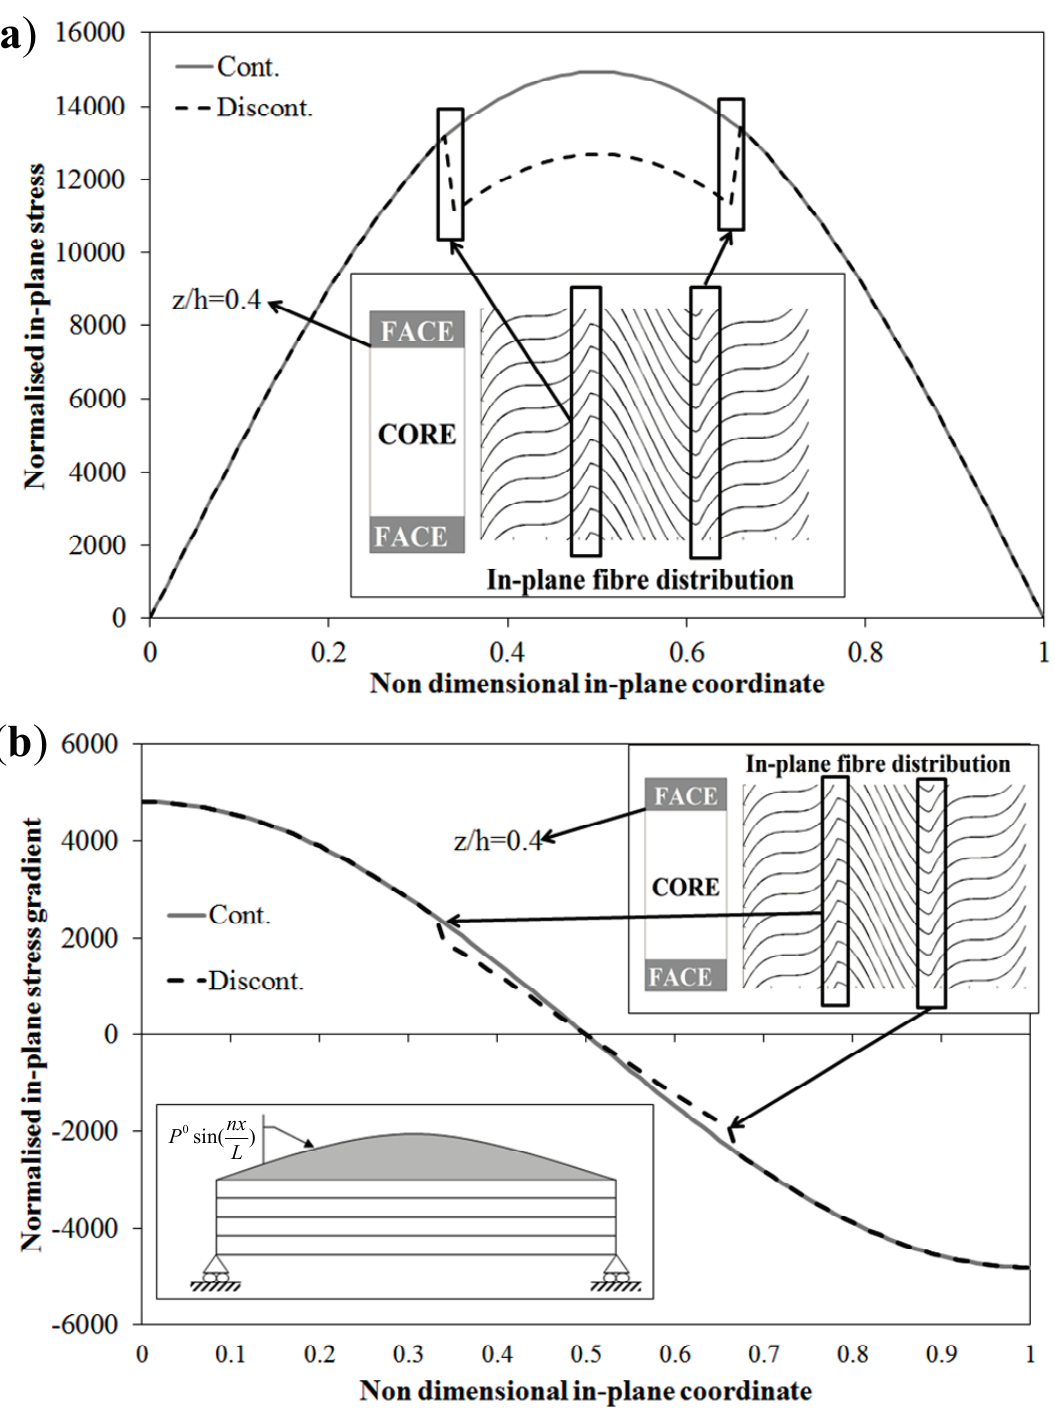
Figure 9. Sandwich beam with step variation of fiber orientation: non-dimensional in-plane variation of ( a ) in-plane stress and ( b ) in-plane stress